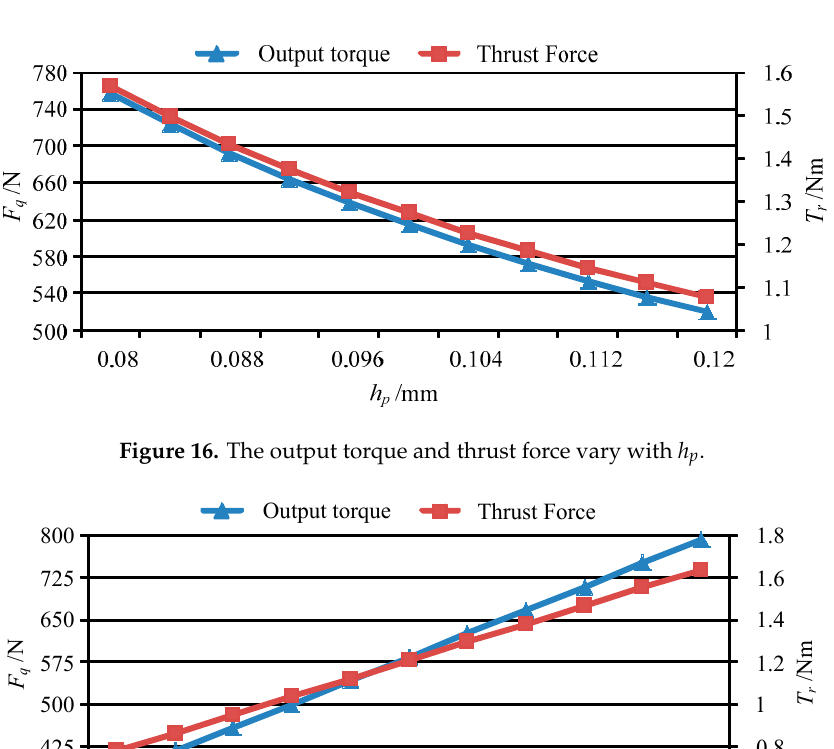
Figure 15. The output torque and thrust force vary with c 33 .